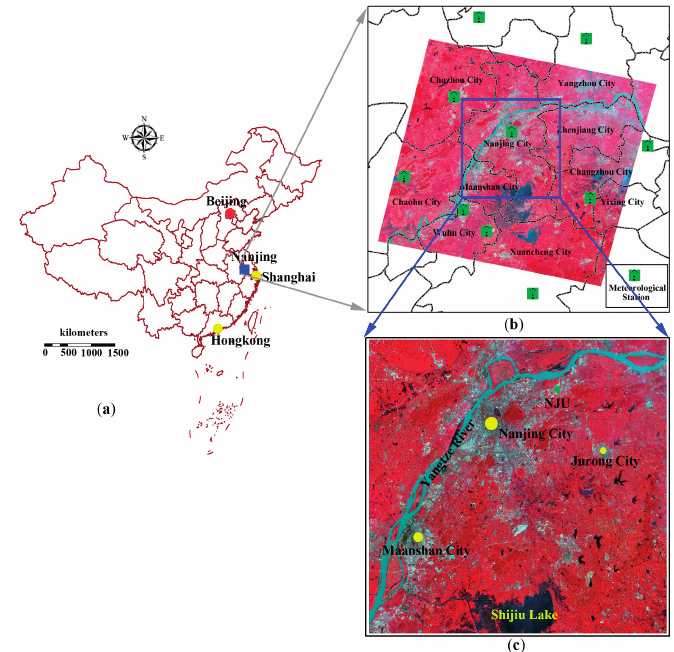
Figure 6. Application of the algorithm to Nanjing and its vicinity in east China. ( a ) The geographic location of Nanjing and its vicinity in China; ( b ) the spatial distribution of meteorological stations around the region; ( c ) pseudo-color composite (RGB: 5, 4, 3) of Landsat 8 OLI data of the